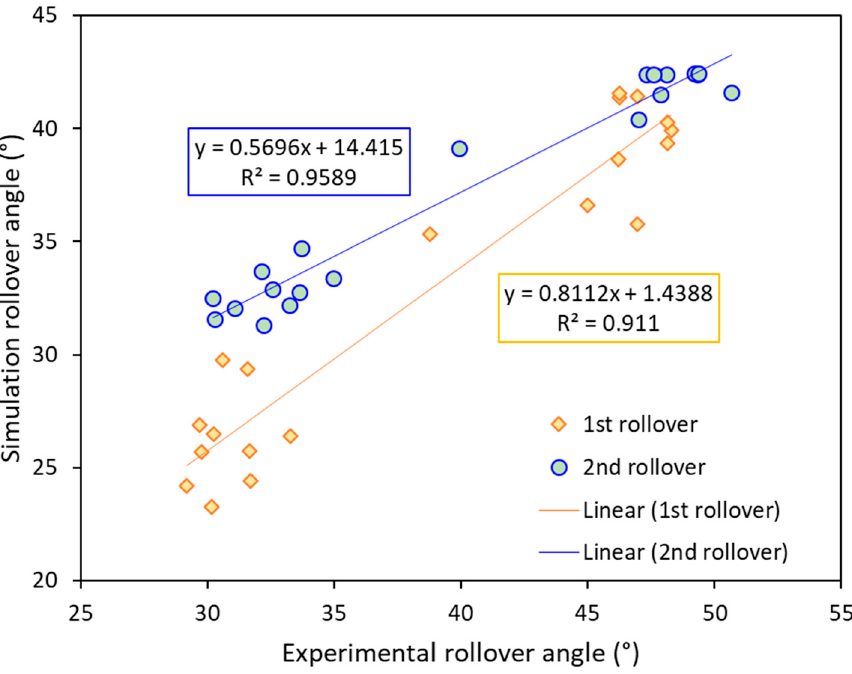
Figure 9. The verification of the simulation of first and second rollover angles of the radish harvester for the defection angles of 0 and 180°.